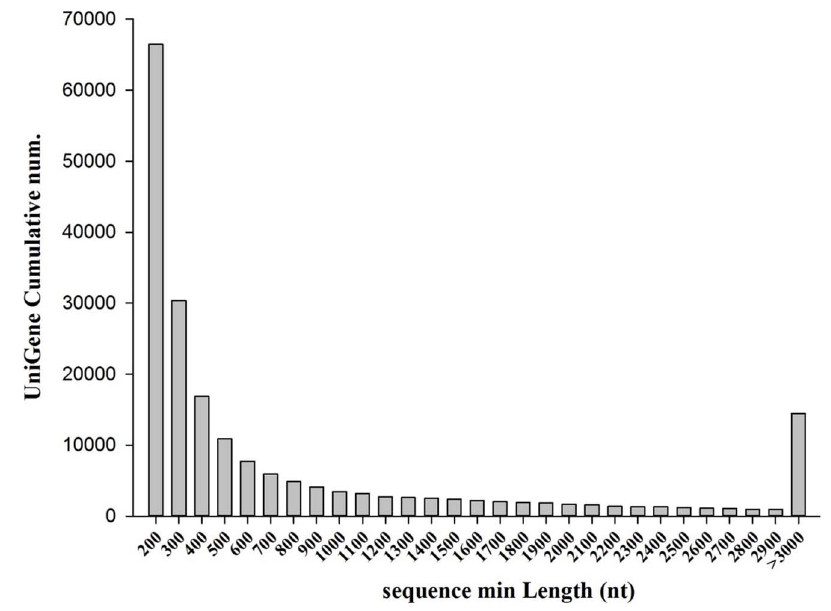
Figure 1. Length distribution of assembled unigenes in the sequenced cDNA library.